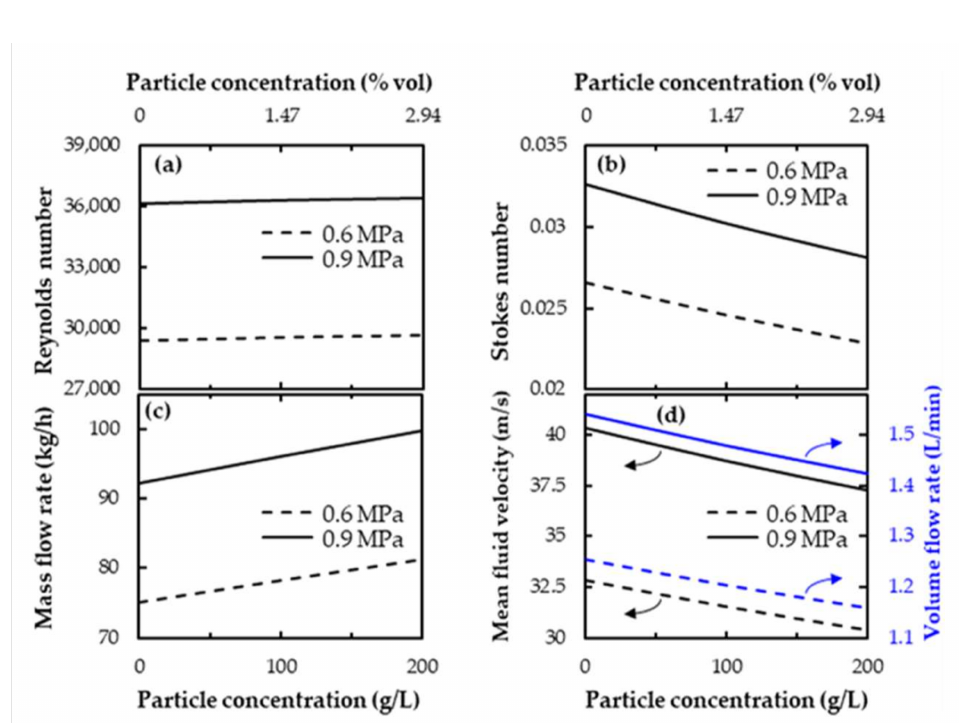
Figure 9. Variation of ( a ) Reynolds number, ( b ) Stokes number, ( c ) liquid mass flow rate and ( d ) liquid velocity at the nozzle exit (black lines), and liquid volume flow rate (blue lines) due to different inlet pressure (0.6 MPa in dashed lines and 0.9 MPa in solid lines) and particle